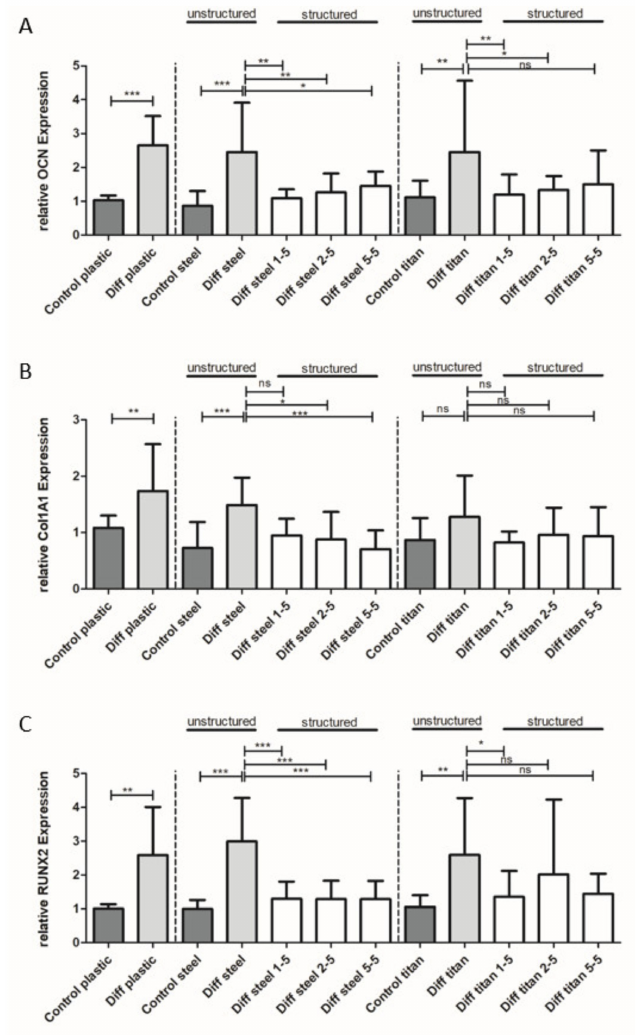
Figure 8. The influence of plate structuring on osteogenic di ff erentiation. The gene expression analysis of osteogenic genes after 4 weeks of di ff erentiation of human mesenchymal stem cells. Di ff erentiation of MSCs according to gene expression was successful on polystyrene (plastic), steel, and titanium surfaces, while Collagen 1 expression was not changed after di ff erentiation on titanium plates. OCN ( A ) and RUNX2 ( C ) expression was inhibited by all structured plates, while Collagen 1 expression ( B ) was reduced on structured steel plates only. * ( p < 0.05), ** ( p < 0.005), *** ( p < 0.0005), ns